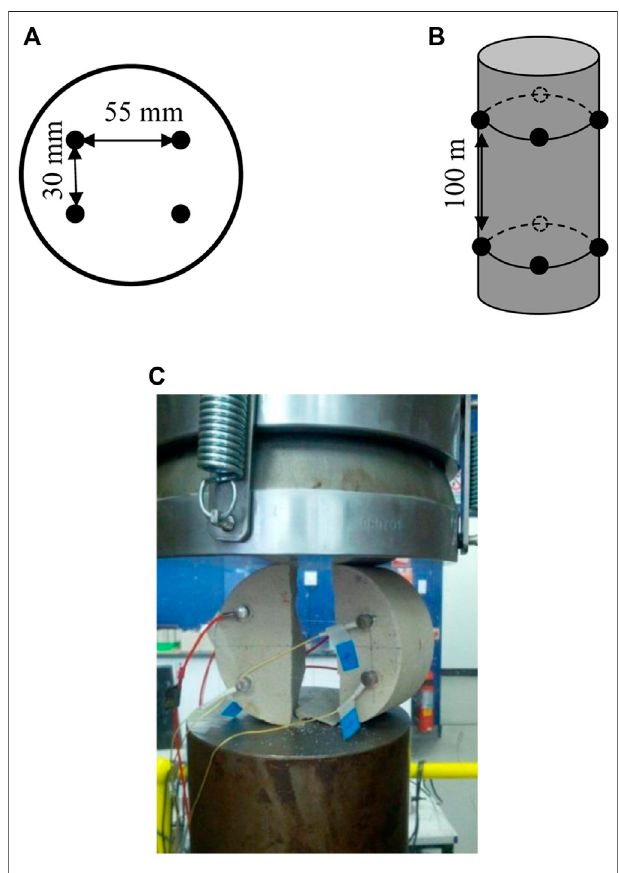
FIGURE 2 | Distribution of sensors (black dots) for (A) Brazilian test and (B) uniaxial compression test. In (A) the arrangement of the sensors on the rear face is the same as the one in the front face. (C) Arrangement of a test specimen after the Brazilian test.